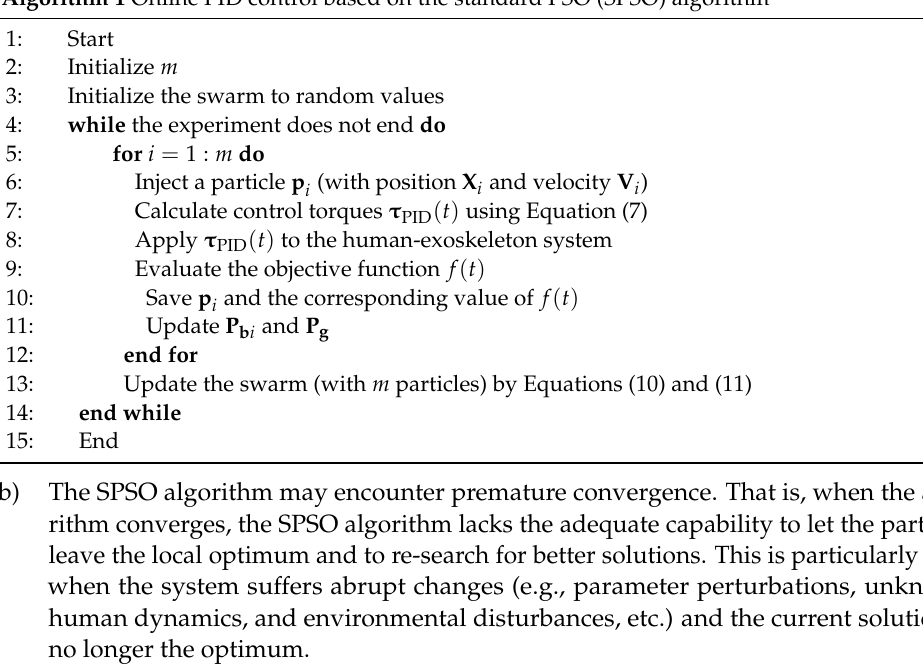
Algorithm 1 Online PID control based on the standard PSO (SPSO)